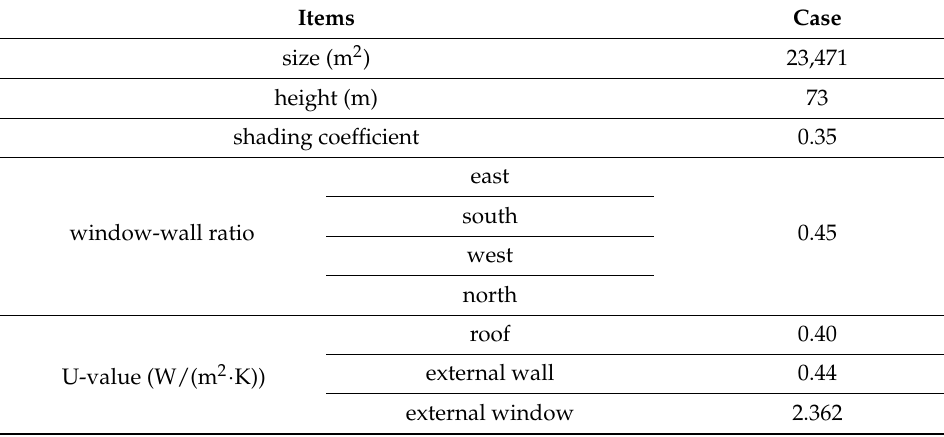
Table 2. Physical model parameters for thermal properties.